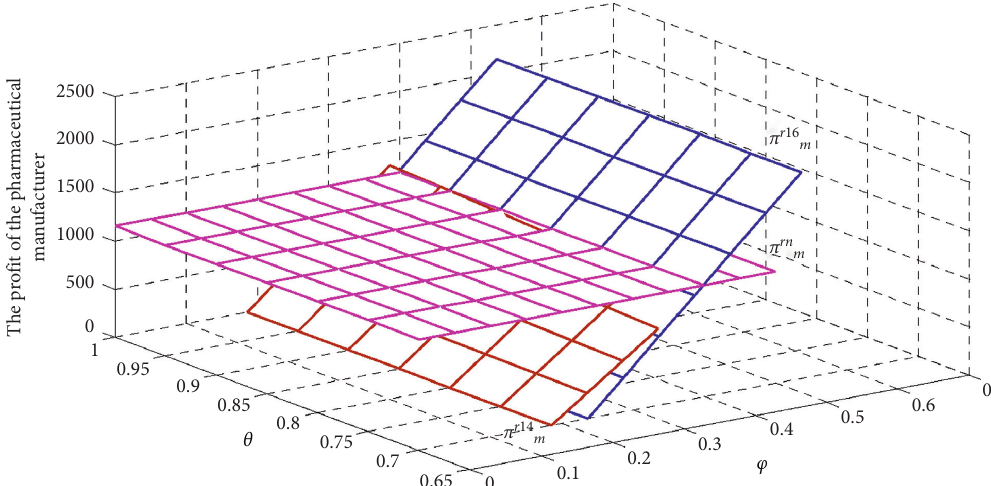
Figure 4: The profit of the pharmaceutical manufacturer under linkage price cap regulation.